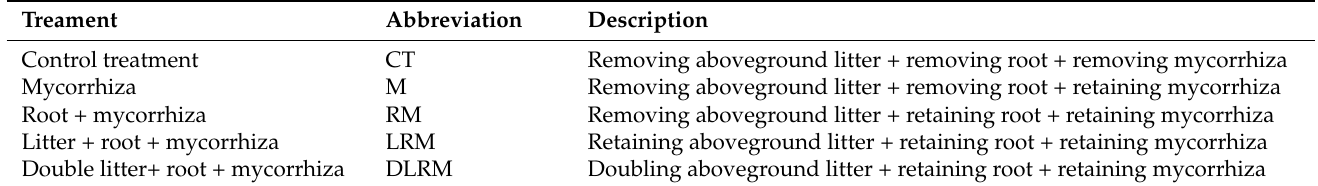
Table 1. List of